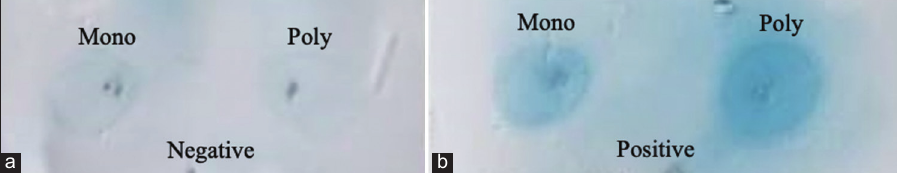
Figure-1: The result of dot blotting using monovalent and polyvalent antigens of live attenuated African horse sickness virus vaccine. (a) Negative result; (b) Positive result; Mono=Monovalent antigen; Poly=Polyvalent